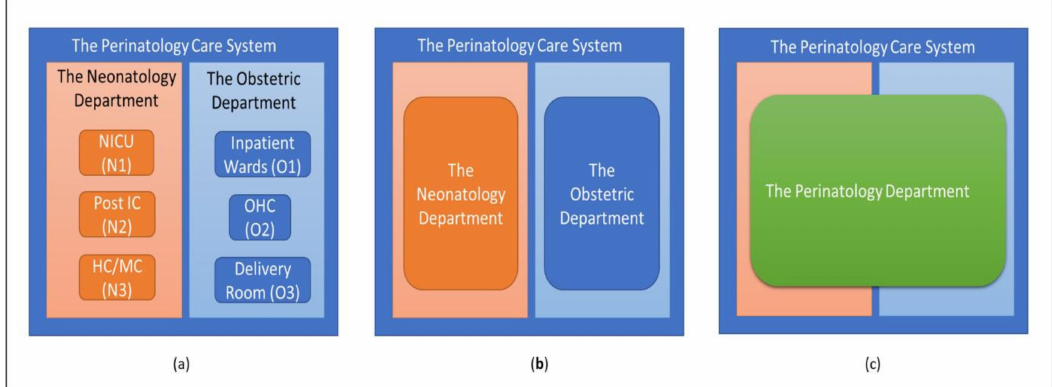
Figure 2. Care system configurations. Part ( a ): two departments in the current configuration, in which each department has three separate units and dedicated resources. Part ( b ): the resources of the three units in each department are pooled. Part ( c ): the care system consists of one large department (with its resources) to care for mothers and